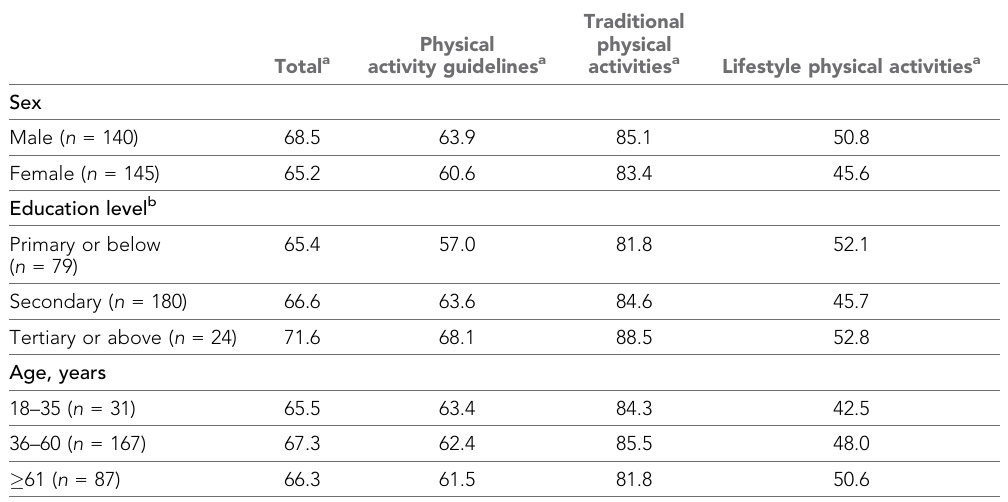
Table 4. Knowledge of Centers for Disease Control and Prevention/American College of Sports Medicine PA guidelines by demographic groups